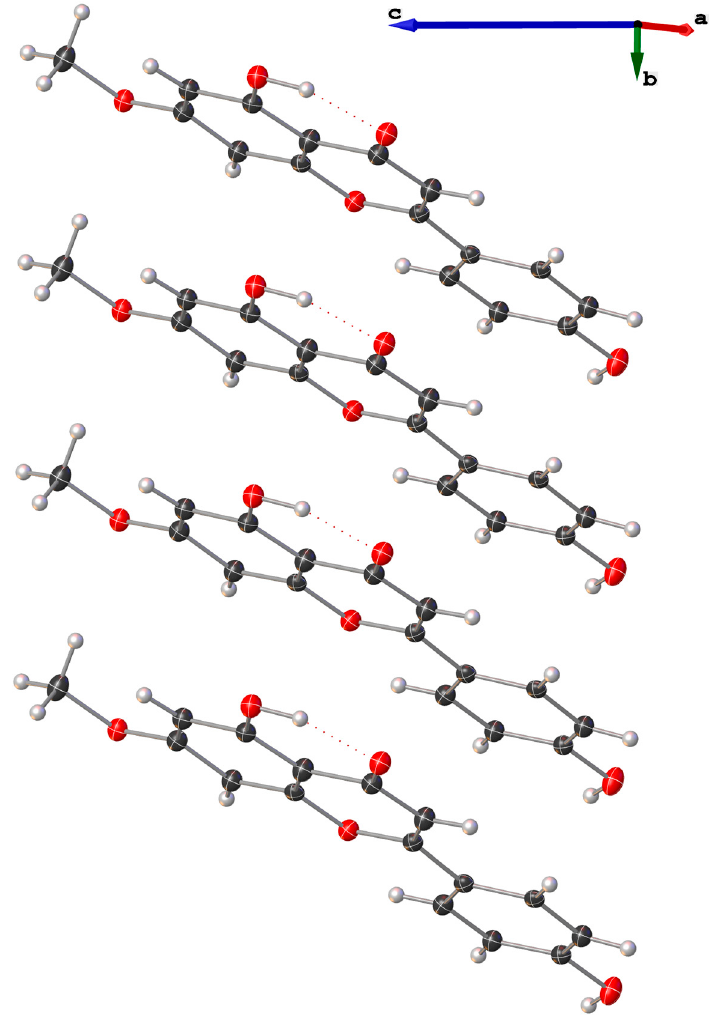
Figure 4. An infinite one-dimensional chain of π -stacked Genkwanin molecules ( 1a ) the molecules are tilted but the chain is coincident with the b -axis with a separation of (3.8663 (7) Å). The stacking dictates the length of the b -axis.